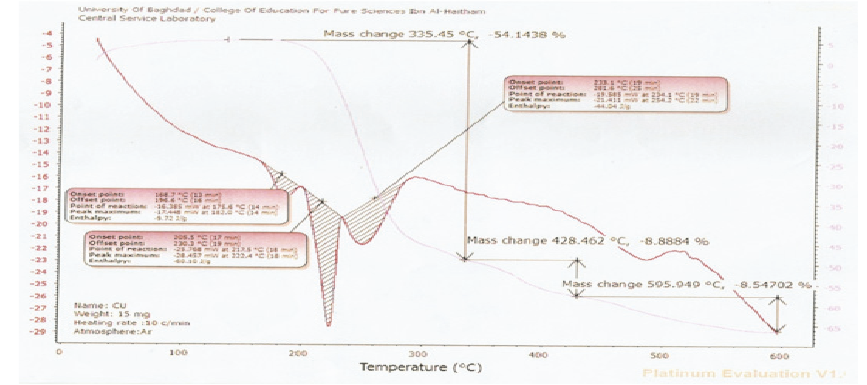
Figure 6: TG/DTG and DSC thermogram of [Cu(L 1 )(L 2 ) H 2 OCl] in argon atmosphere biological